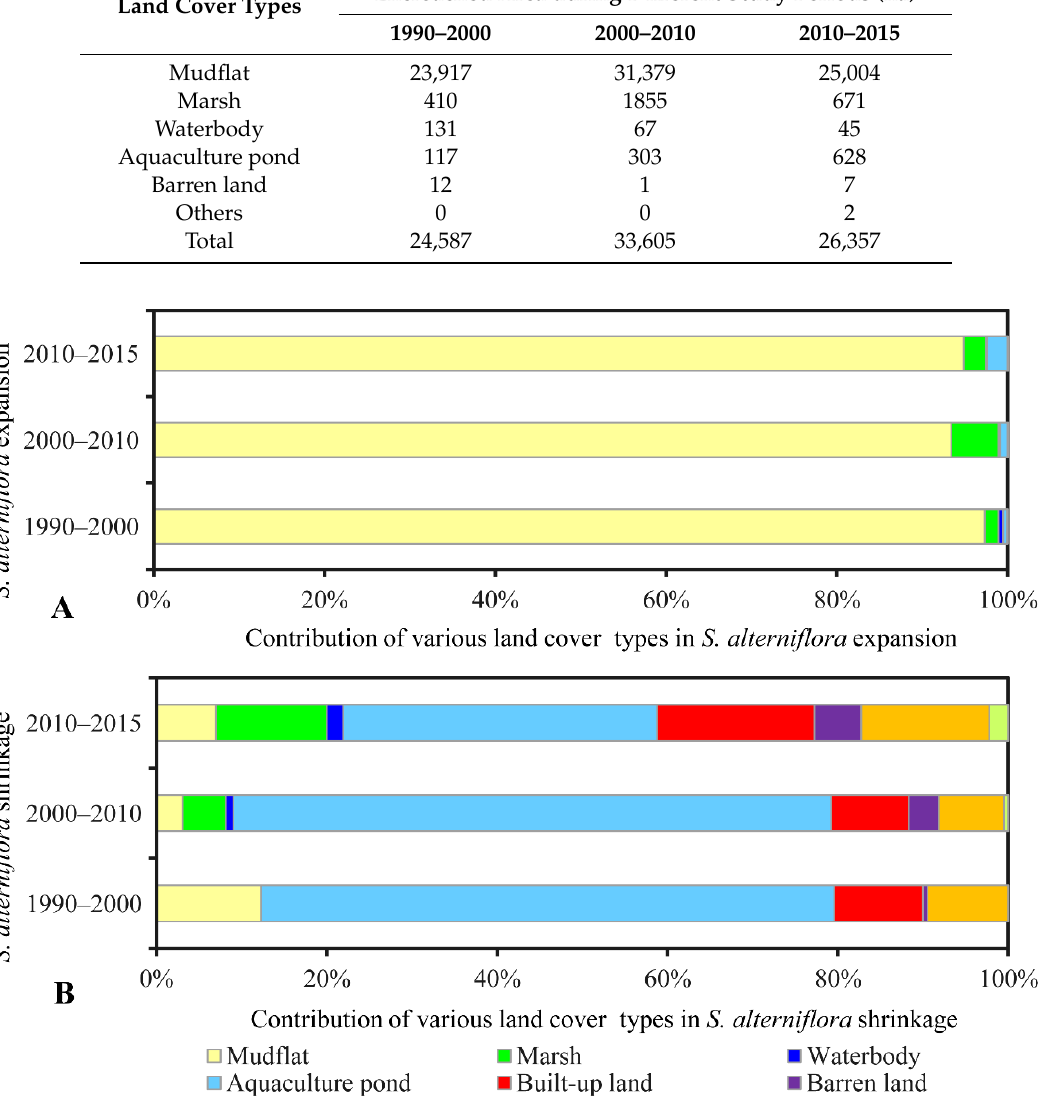
Table 3. Encroached area of invasive S. alterniflora to various land cover types during the different study periods.